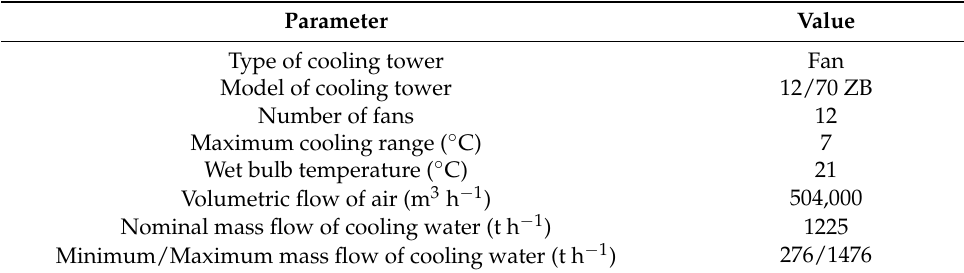
Table A6. Parameters of cooling towers. Source: [64].